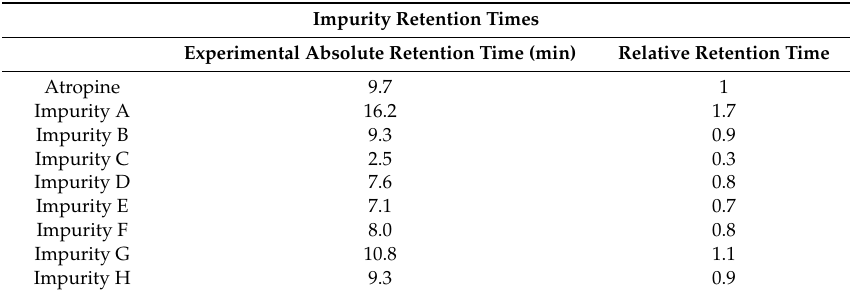
Table 3. Atropine impurities retention times and relative retention times.